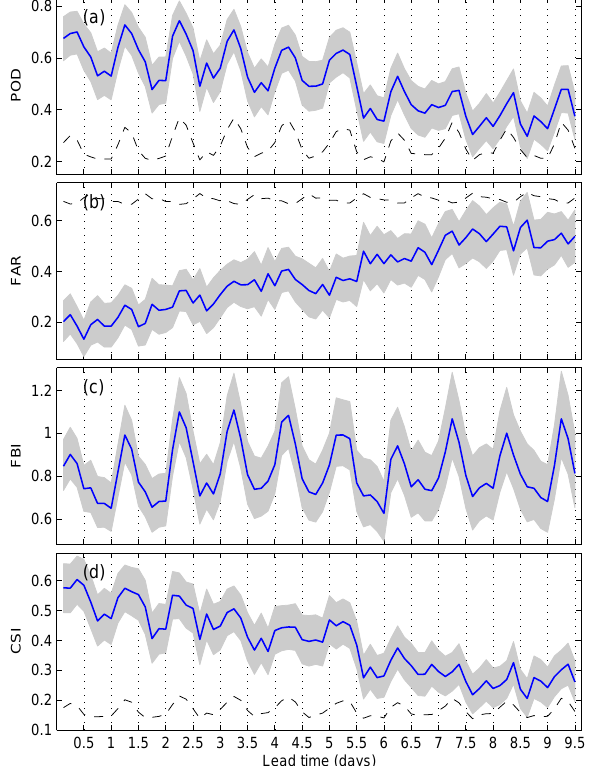
Fig. 12. As in Fig. 7, but for the catchment average precipitation above Wangaratta stream gauging station: (a) POD, (b) FAR, (c) FBI, and (d) CSI. The mean scores (except FBI) of the reference forecasts are also shown in dashed